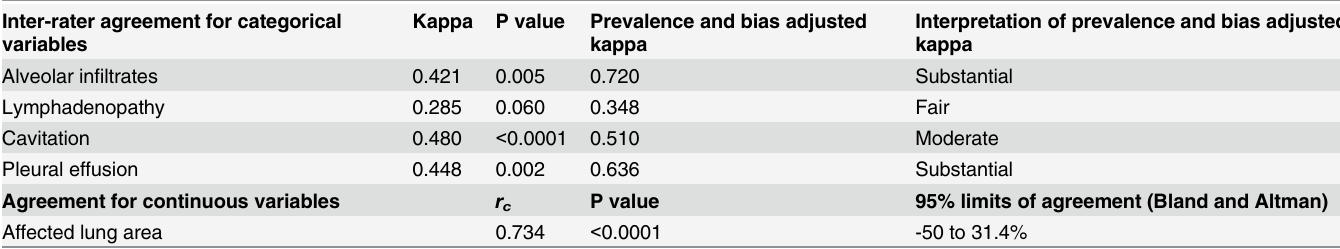
Table 4. Inter-rater agreement on Chest Radiograph (CXR) findings.